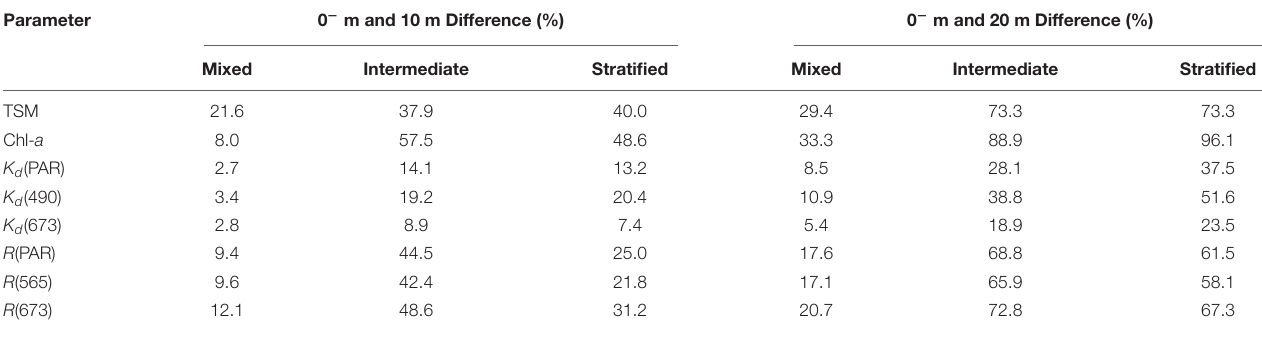
TABLE 4 | Differences (%) between the concentration of optically significant constituents (OSC) such as the concentration of total suspended matter (TSM) and chlorophyll- a (Chl- a ), and the spectral diffuse attenuation coefficient ( K d ( λ )) and the spectral irradiance reflectance ( R ( λ )) at different wavelengths by respective depths and hydrodynamic